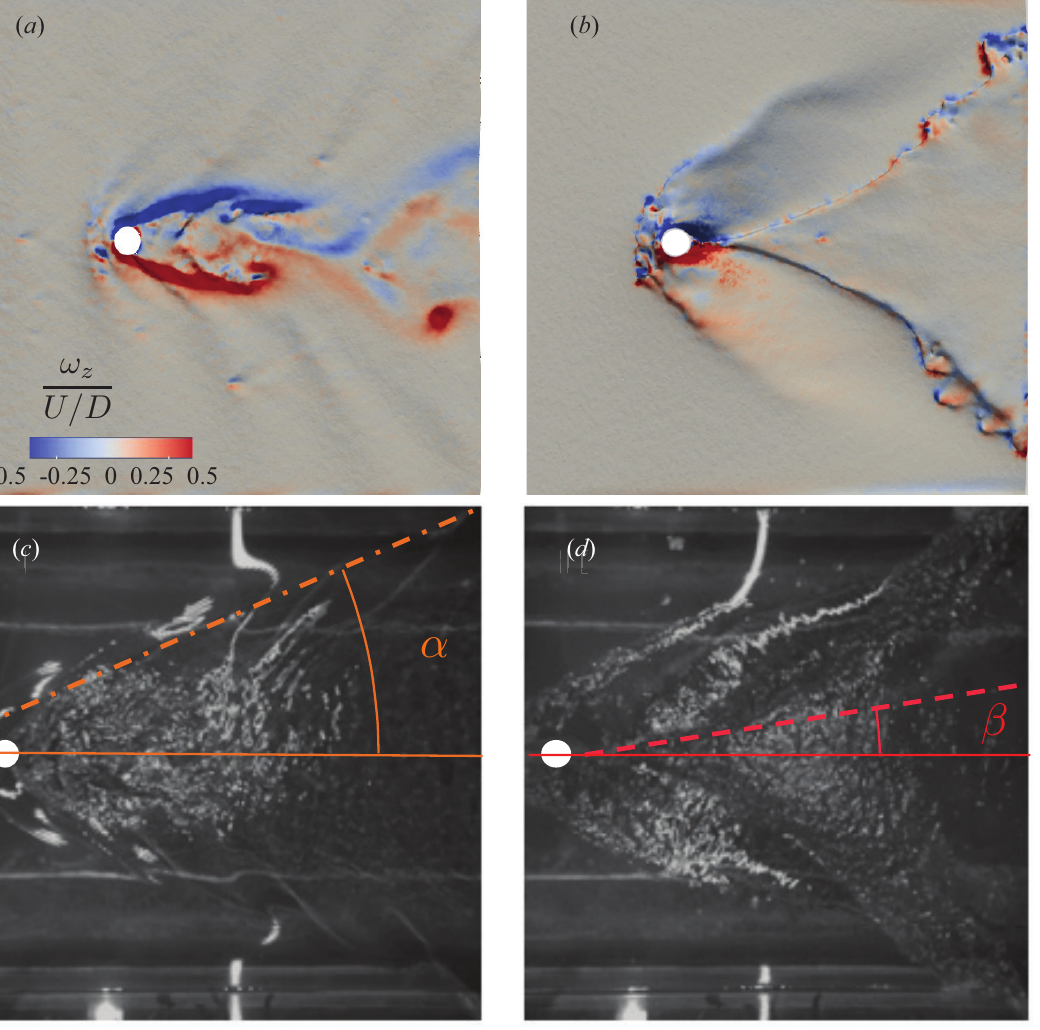
Figure 4. Instantaneous ( Ut / D = 60) vertical dimensionless vorticity component at the free surface for D = 5 cm with ( a ) Re = 30,000 or Fr = 0.86 and ( b ) Re = 60,000 or Fr = 1.72. The associated experimental visualization of the free-surface: ( c ) Re = 30,000 or Fr = 0.86 with the dotted-dashed lines representing approximately the half-angle α and ( d ) Re = 60,000 or Fr = 1.72 with the dashed lines sketching the approximate half-angle β .